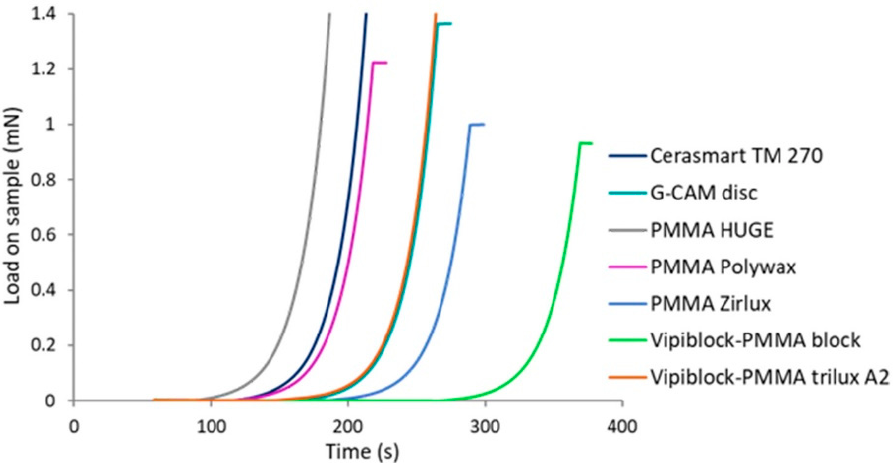
Figure 3. Graphical representation of load as function of time curves at the loading stage of the investigated CAD/CAM restorative specimens under nanoindentation.